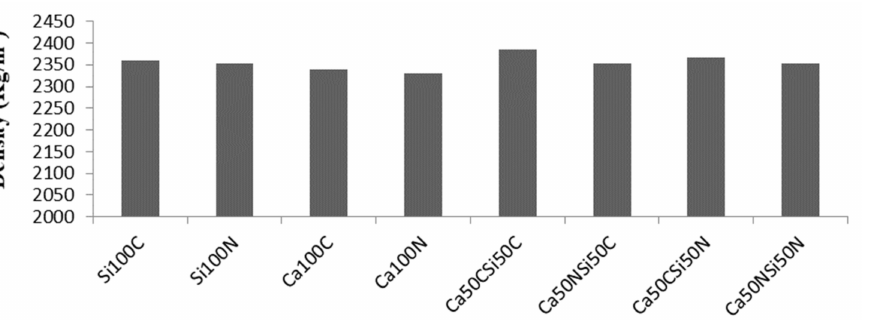
Figure 8. The bulk density of different